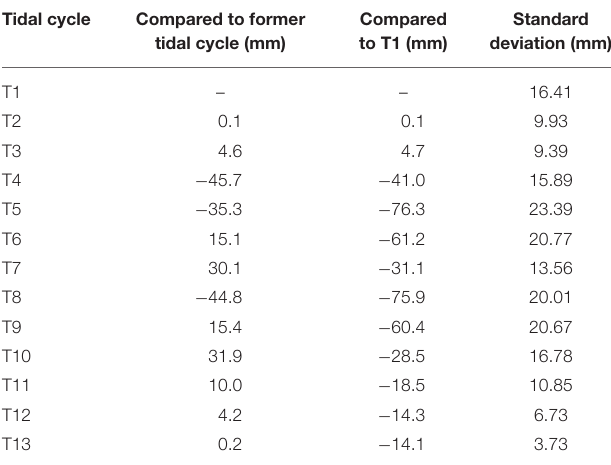
TABLE 3 | The comparison of tidal cycle-averaged DSPs between different tidal cycles (negative value indicated erosion and positive value indicated accretion for beach bed level), and the standard deviation of intra-tidal bed level changes of each tidal cycle.